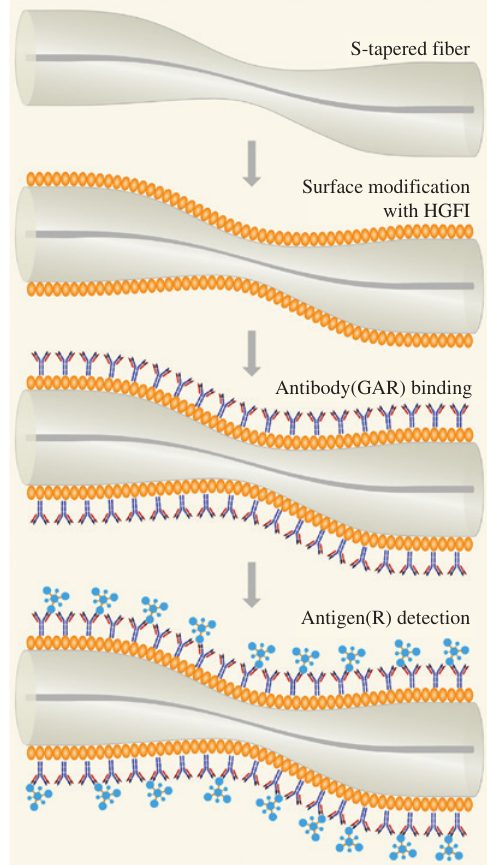
Figure 4: Schematic representation of the fibre surface modification and detection